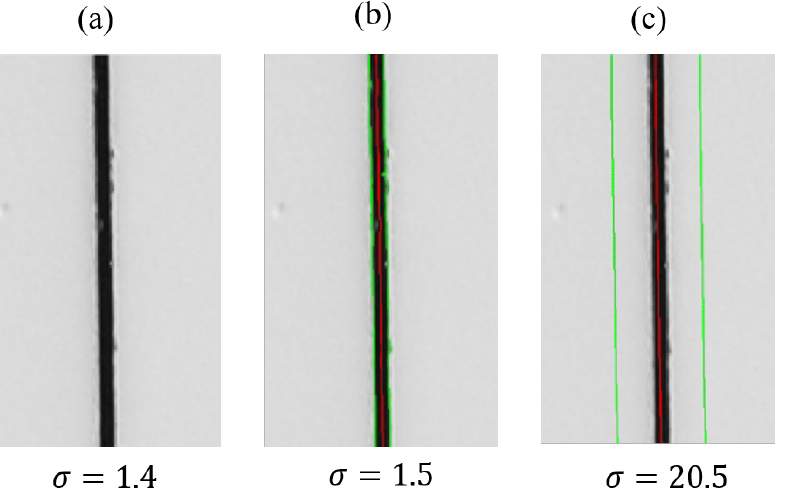
Figure 31. The optimization algorithm identifies the transition point between the unidentified groove condition ( a ) and the correctly identified one ( b ). As the σ value increases, the algorithm continues to identify the centerline well but overestimates its width value ( c ), represented by the green lines in the figure.